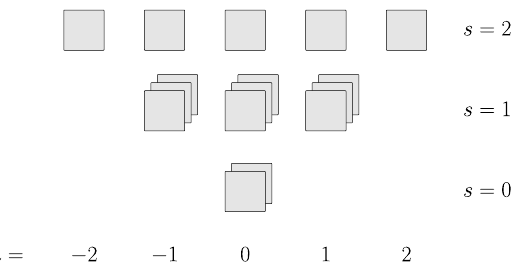
Figure 2: The decomposition of our Hilbert space using quantum numbers s , m and r , here depicted for the case of four spin- 1 particles. For each total spin s = 0,1 or 2 2 (vertical), the 2 s + 1 possible z -magnetizations m are laid out horizontally. The { 0,1,2 } multiplicities of the spin spaces N are 2, 3 and 1, respectively, and states that 1 , 1 , 1 , 1 2 2 2 2 differ by multiplicity-label r are depicted in the depth-dimension. This way, each square corresponds to single state. The Hamiltonian H must preserve labels s and m , hence perturbing J can only excite states that differ in label r jk